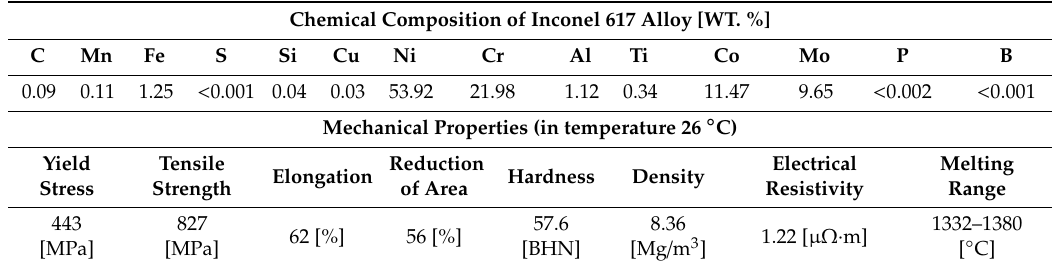
Table 3. Chemical composition of Inconel 617 alloy and its mechanical